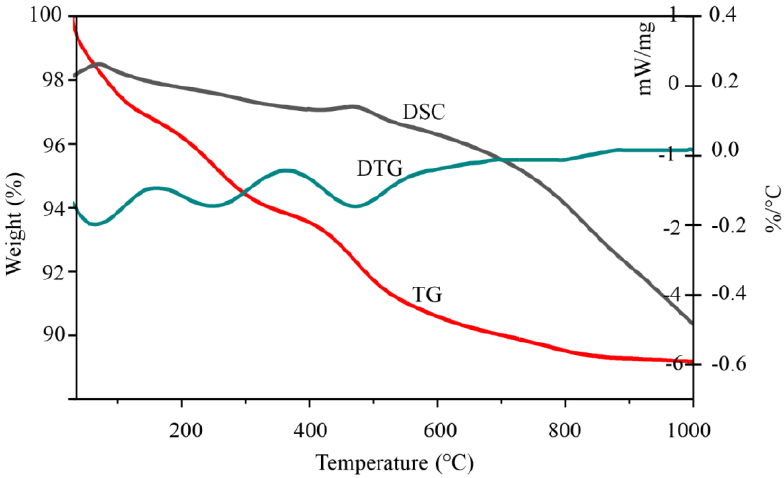
Figure 2. TGA curves of the studied raw diatomite sample.